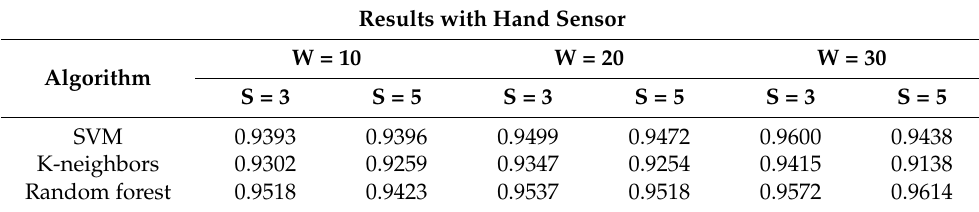
Table 5. Maximum values obtained for the right classifier in two-sensor mode. Results with Hand